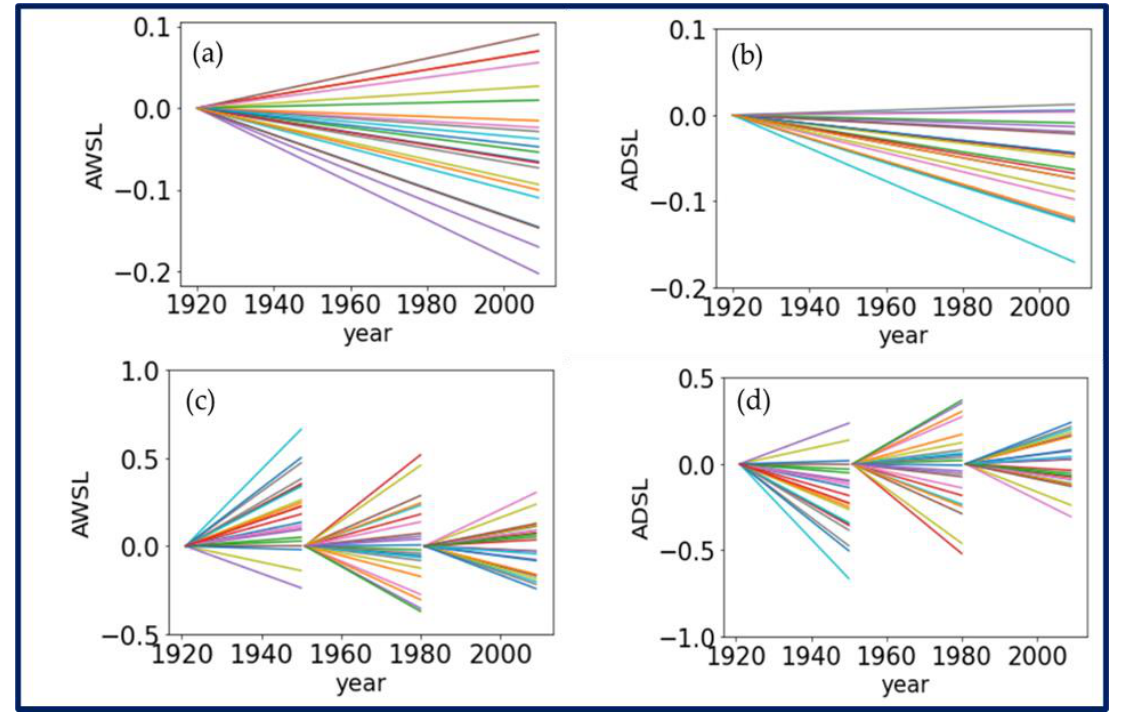
Figure 10. Kansas station trends in the annual wet spell length (AWSL) between 1980 – 2009 ( a ) and annual dry spell length (AWDL) ( b ). The data in ( c , d ) is the same as that in ( a , b ), respectively except